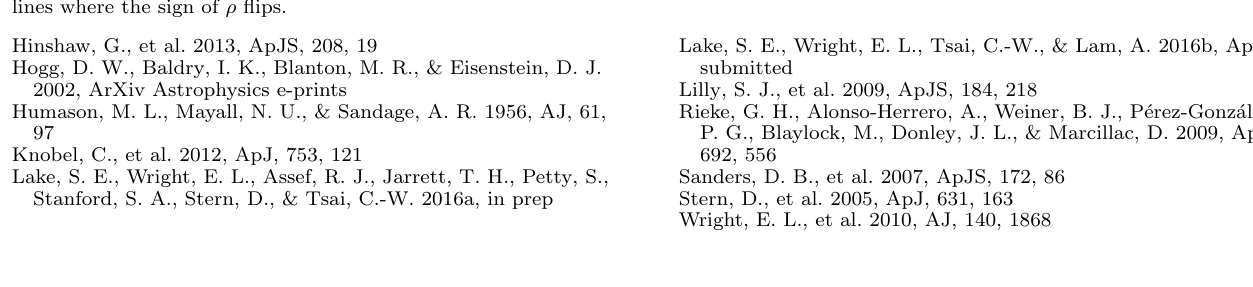
Figure 6. SED correlation functions, ρ ( ν, ν (cid:48) ) = Σ( ν, ν (cid:48) ) / (cid:112) Σ( ν, ν )Σ( ν (cid:48) , ν (cid:48) ). Panel a shows ρ for all galaxies, while b , c , and d show ρ for AGN, red, and blue galaxies, respectively. The dominant feature in the graphs, the sign flips across the λ { 1 , 2 } = 2 . 4 µ m axes, is due to the choice of normalizing the SEDs to that wavelength. The impact of spectral features, emission and absorption lines, in the templates also stand out as horizontal and vertical striping. The final feature worth noting is the sign flip that corresponds, roughly, to when the wavelengths are on opposite sides of the point where the template SEDs that dominate the population diverge, generating the thick white lines where the sign of ρ